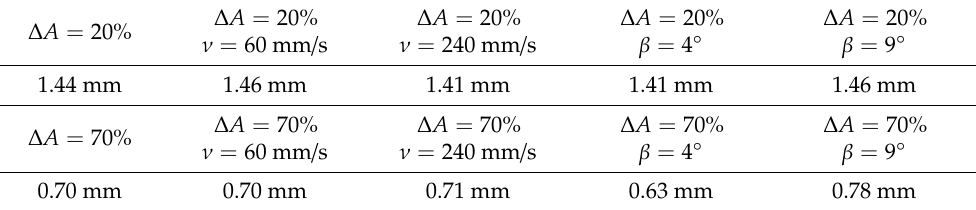
Table 3. Average coating thicknesses after CWR for di ff erent process parameters in the